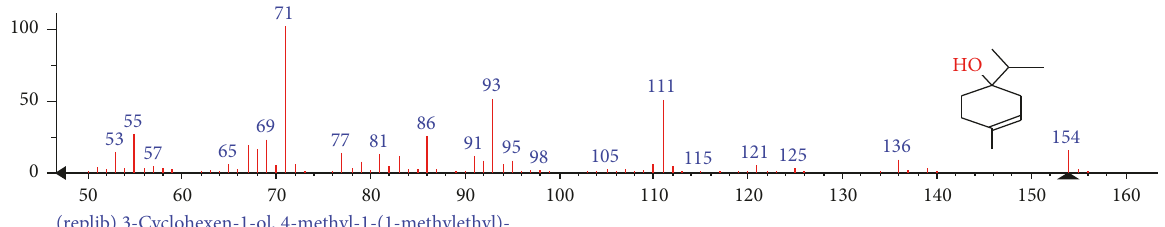
Figure 14: Mass spectrum of compound 3-cyclohexen-1-ol, 4-methyl-1-(1-methylethyl)- of whole plant hexane fraction of Achillea wilhelmsii (WHFAW).